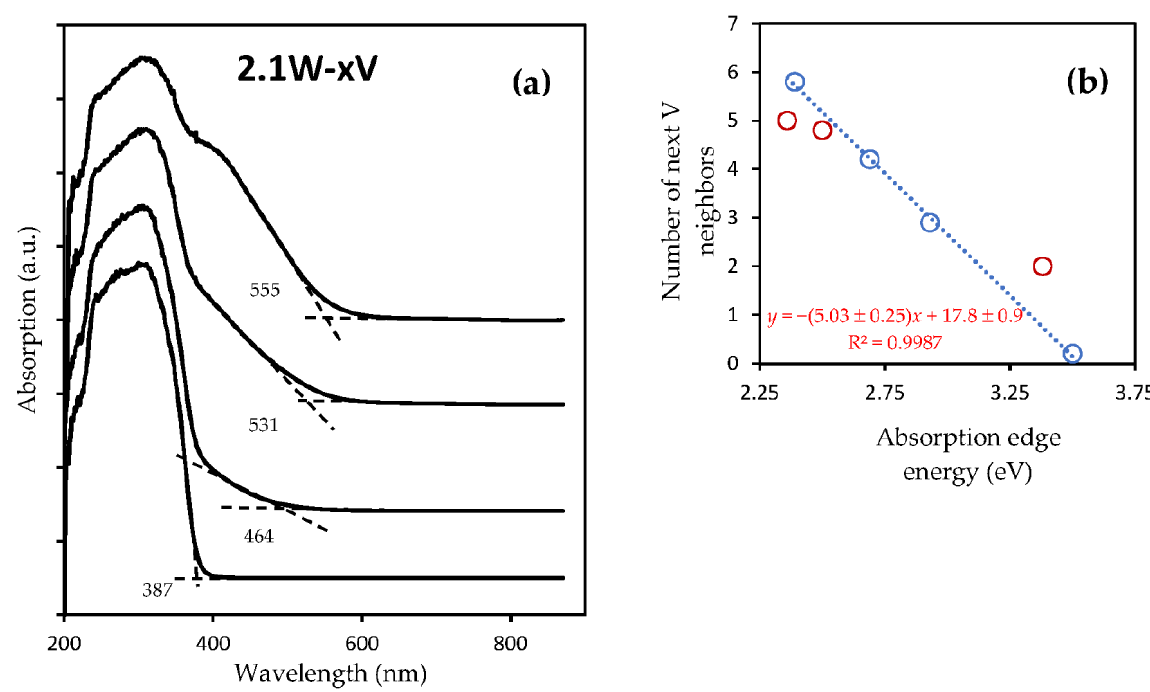
Figure 7. UV-vis spectra recorded for the series 2.1W- x V ( a ) and relationship between the estimated absorption edge value from Figure 7a and the number of next V neighbors in VO x clusters ( b ). Red circle data from reference [27], blue circle data from reference [28]. Table 5. Textural properties and spectral features extrapolated from UV-vis spectra recorded for V 2 O 5 -WO 3 /TiO 2 .